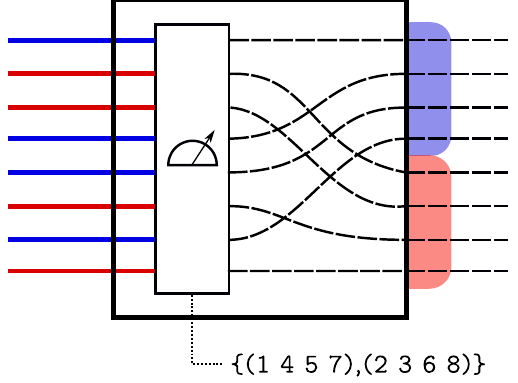
FIG. 1. Pictorial representation of the clustering device for an input of eight quantum states. States of the same type have the same color. States are clustered according to their type by performing a suitable collective measurement, which also pro- vides a classical description of the